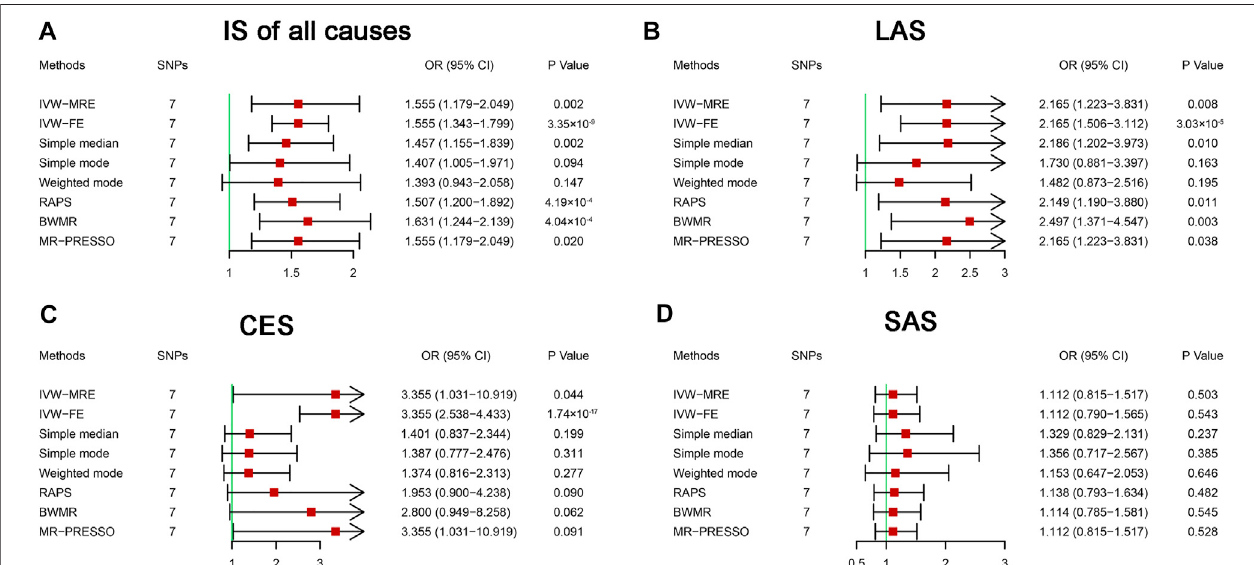
FIGURE 2 | Mendelian randomization analysis of the effect of heart failure on ischemic stroke. BWMR, Bayesian weighted Mendelian randomization; CES, cardioembolic stroke; CI, con fi dence interval; IS, ischemic stroke; IVW-FE, inverse variance-weighted- fi xed effects; IVW-MRE, inverse variance-weighted-multiplicative random effects; LAS, large artery atherosclerosis stroke; MR-PRESSO, Mendelian randomization pleiotropy residual sum and outlier; OR, odds ratio; RAPS, robust adjusted pro fi le score; SAS, small artery occlusion stroke; SNP, single nucleotide polymorphism. Bonferroni corrected p -value (cid:1) 0.0125.